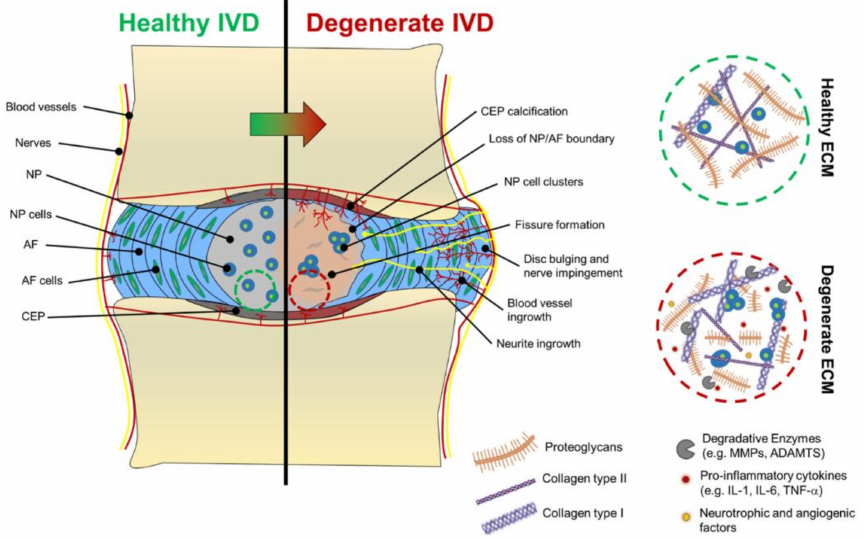
Figure 2. Visual summary of the macroscopic and microscopic changes during intervertebral disc degeneration (IDD). Reprinted from an open access source